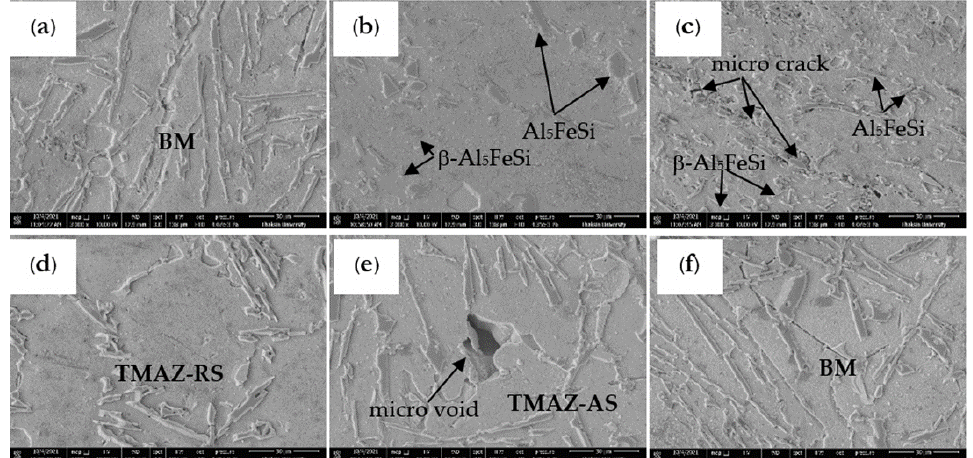
Figure 12. The characteristics of the Al 5 FeSi intermetallic compound evaluation by SEM (6000×) of the optimal welding conditions of MOVaNSAS: ( a , f ) BM, ( b , c ) SZ, ( e ) TMAZ-AS, and ( d ) TMAZ- RS.